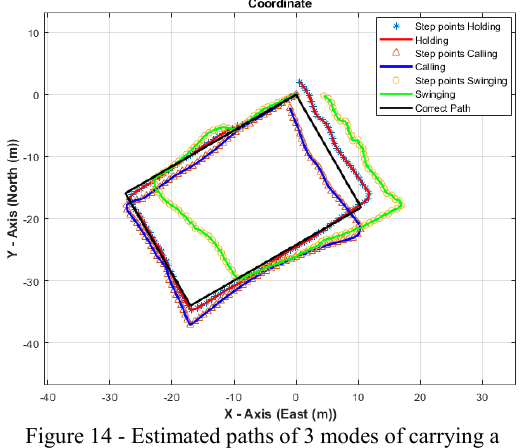
Figure 14 - Estimated paths of 3 modes of carrying a smartphone during the